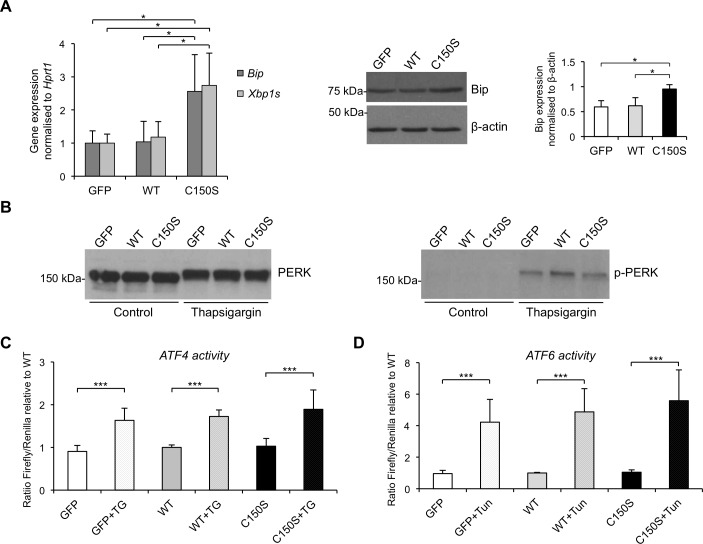
UPR induction in mTAL cells expressing wild type or C150S mutant uromodulin isoform.(A) Bip and spliced Xbp1 (Xbp1s) expression assessed by real-time RT-qPCR. Expression is normalised to Hprt1 (n = 5 independent experiments) (left panel). Western blot analysis showing increased Bip protein levels in mTAL cells expressing mutant uromodulin (n = 3 independent experiments) (right panel). *P<0.05 (mutant vs wild type, Student t test). (B) Western blot analysis of PERK in mTAL cells expressing uromodulin at baseline and after incubation with tunicamycin (2 μg/mL for 14h). A shift in PERK migration is observed after treatment with tunicamycin, but not at baseline (left panel). Western blot performed with an antibody specific for the phosphorylated (Thr980) form of PERK shows the presence of the phosphorylated protein only in tunicamycin-treated cells (right panel). (C) ATF4 activity, assessed through the use of a luciferase-based, ATF4 reporter construct, is equally negligible in cells expressing wild type or C150S uromodulin, while it is evident in all cells upon thapsigargin treatment (100 nM for 14 h) ***P<0.001 (control vs thapsigargin, Student t test) (n = 6). (D) ATF6 activation assessed through the use of a luciferase-based, ATF6 reporter construct. No ATF6 activation is observed in mutant uromodulin expressing cells. Activation can be observed in all cell lines upon treatment with tunicamycin. ***P<0.005 (control vs tunicamycin, Student t test) (n = 8).